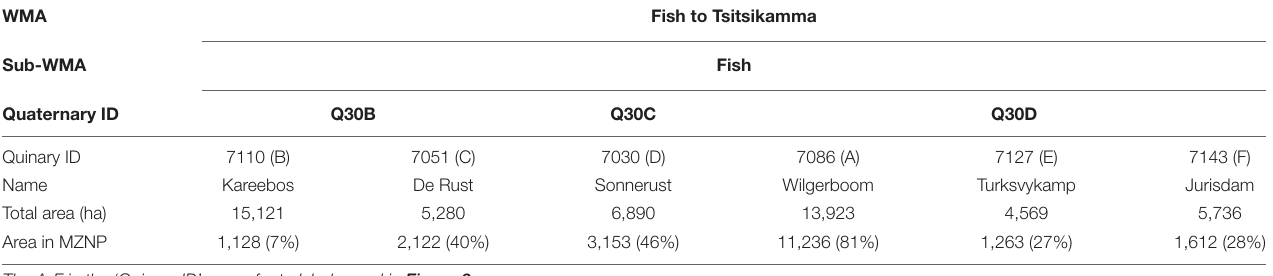
TABLE 2 | Data sources informing the final wetland map of